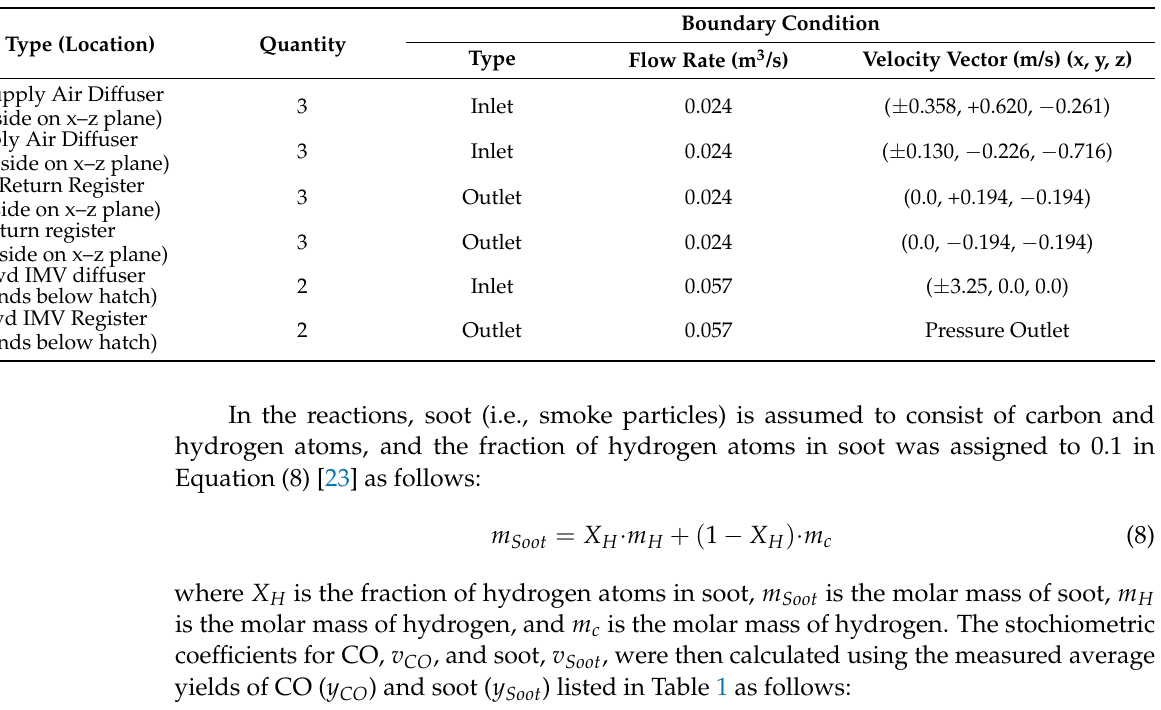
Table 2. Summary of boundary conditions for each ventilation type